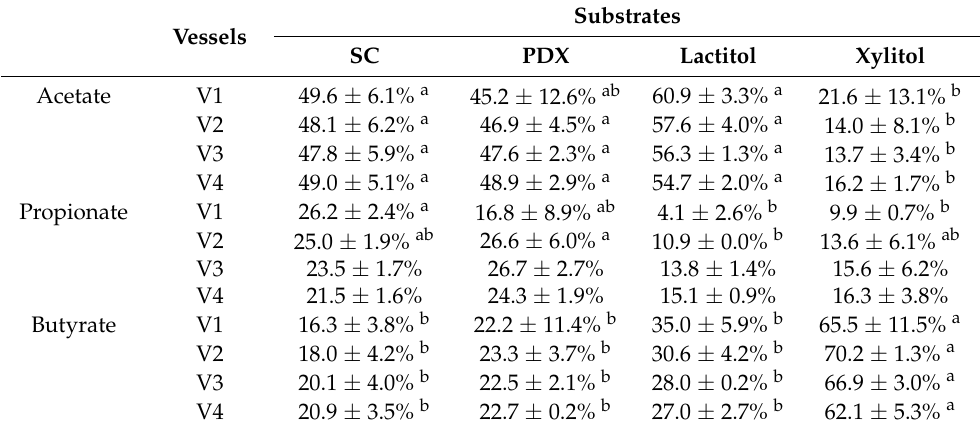
Table 1. Major short chain fatty acids production shown by proportion during in vitro fermentation.